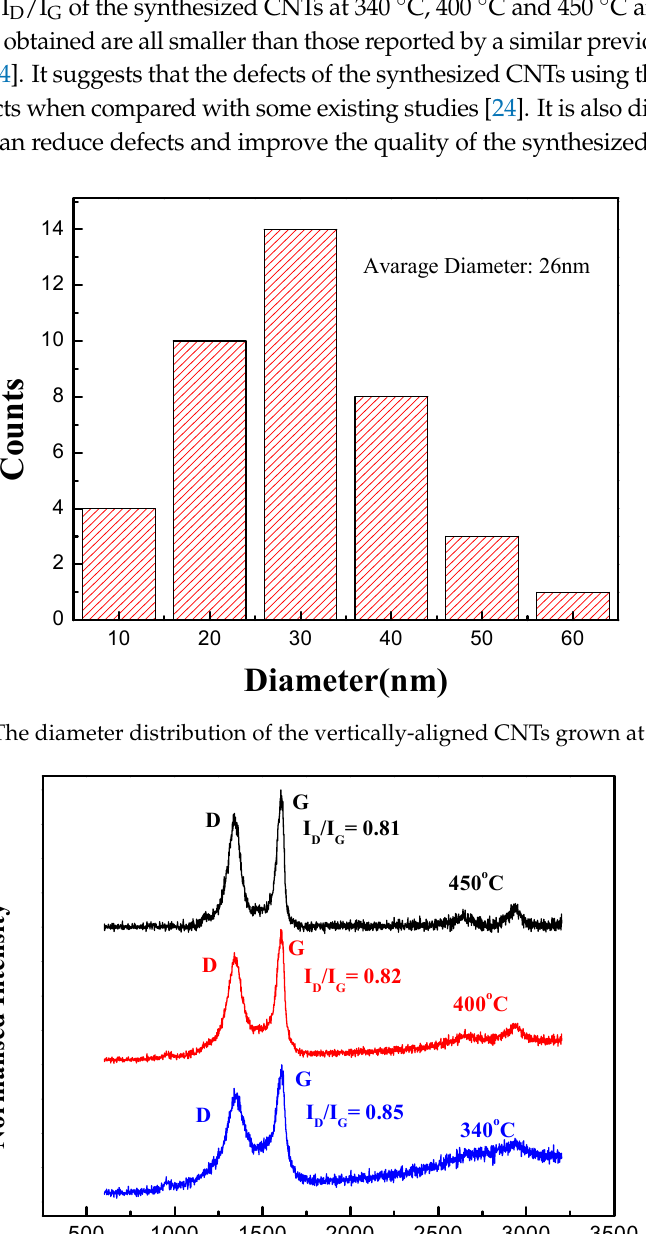
Figure 4. Raman spectrum of the vertically-aligned CNTs grown at 450 °C, 400 °C and 340 °C .